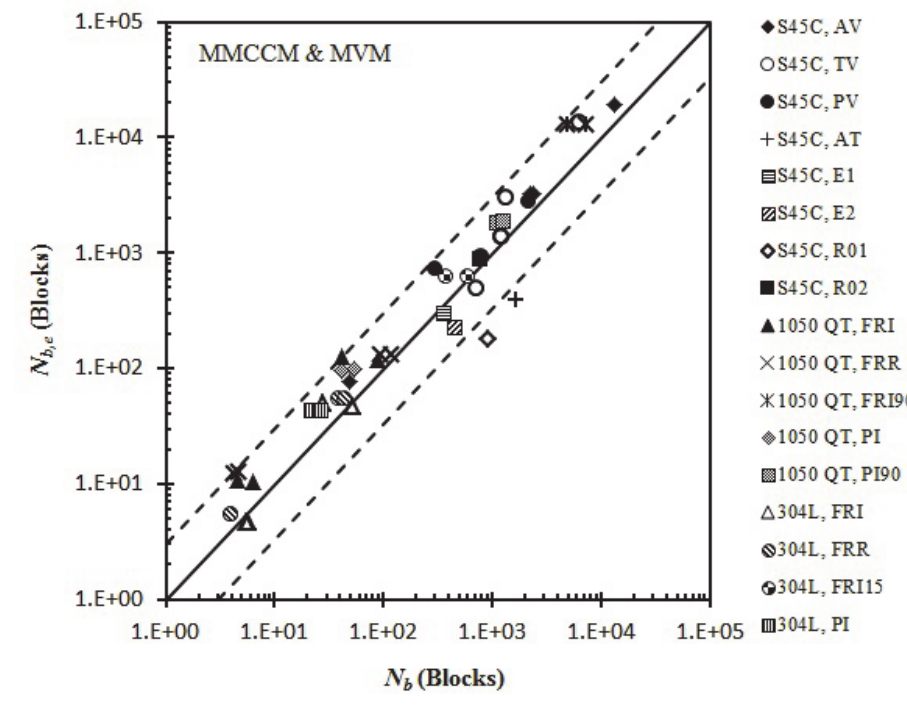
Figure 7: Comparison of observed and predicted fatigue lives by Procedure